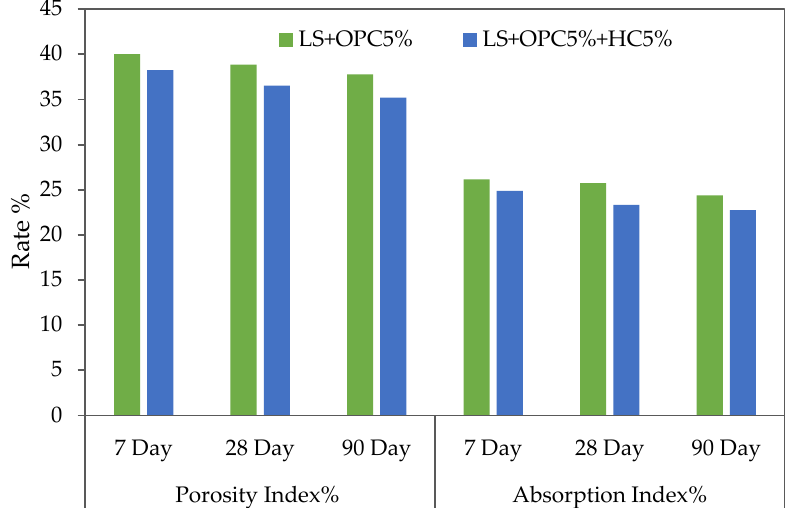
Figure 6. Rate of porosity for cemented lateritic soil with and without caltite.